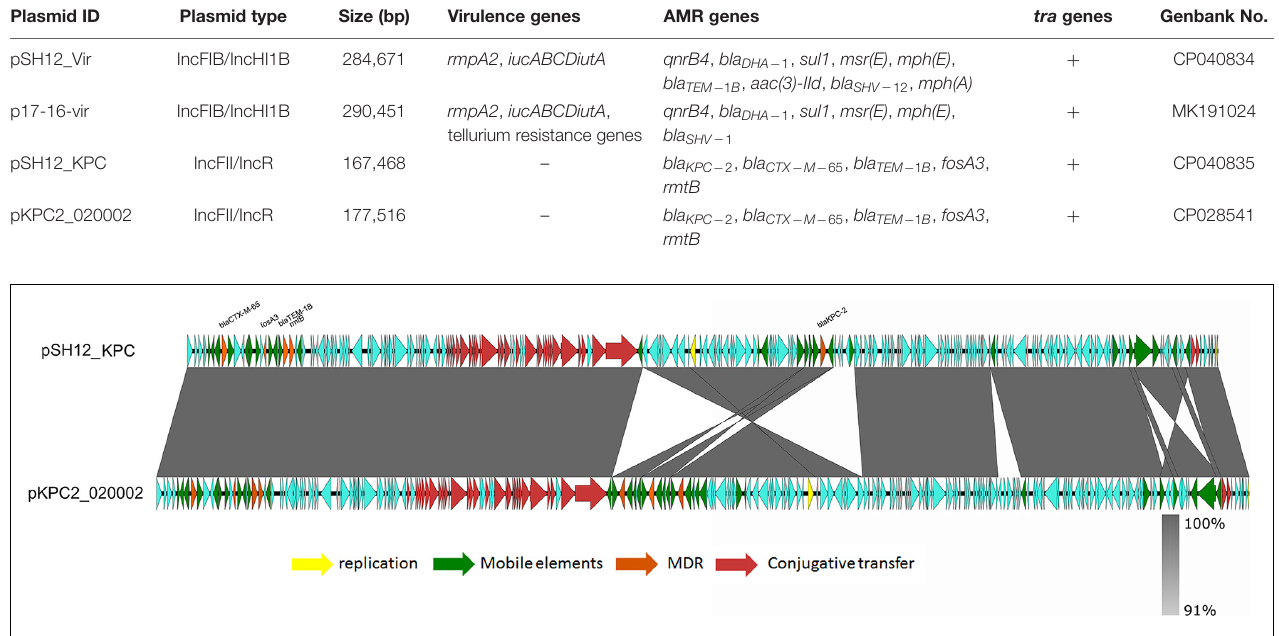
FIGURE 2 | Alignment of pSH12_KPC and plasmid with similar structures. Plasmid pSH12_KPC was highly similar (98% coverage and 99% identity) to plasmid pKPC2_020002 (GenBank accession no. CP028541.2) recovered from a K. pneumoniae strain.